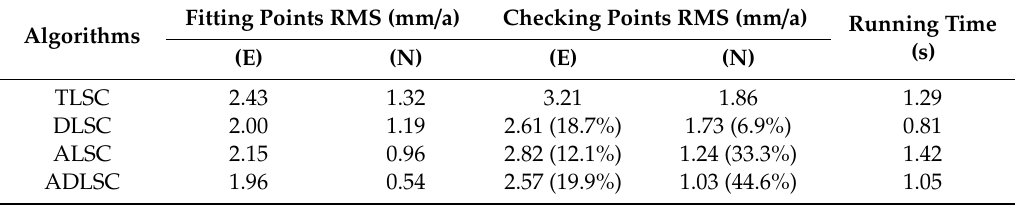
Table 1. Root mean square error (RMS) of the fitting points and checking points using four algorithms. Algorithms